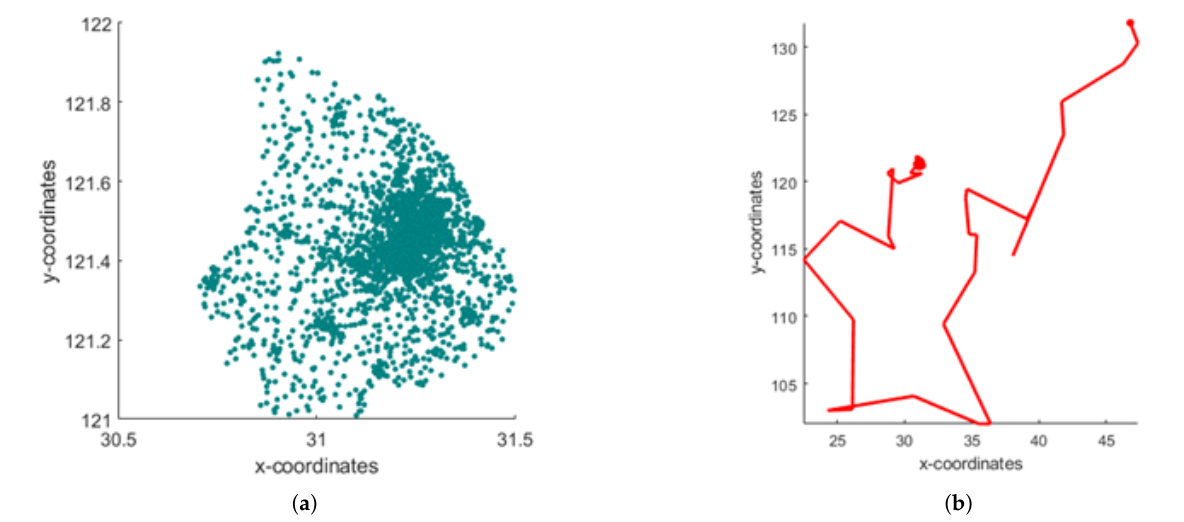
Figure 4. Transformation of base station locations in Shanghai Telecom dataset to contour line. ( a ) Simulated depiction of base station locations. ( b ) Contour line joining nearest base